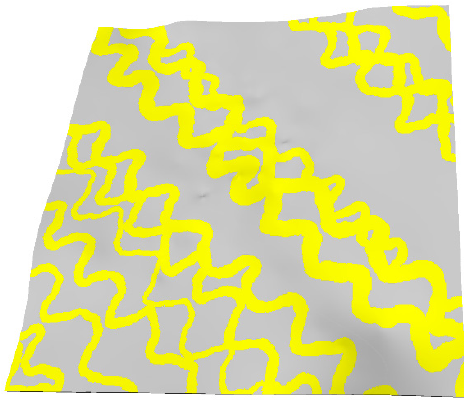
Figure 3. A case study of the meandering stream facies modeling using object-based method: the grey color refers to the background facies, and the yellow color refers to the river channel of the meandering stream facies.